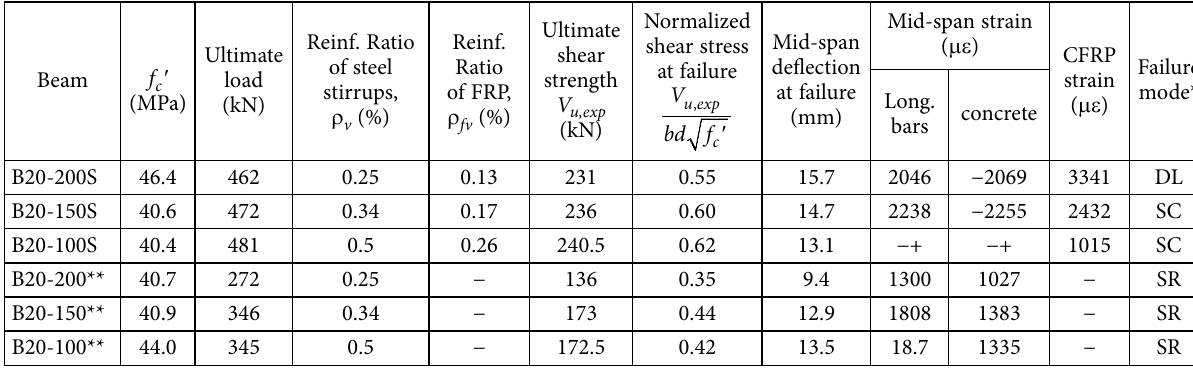
Table 2. Summary of test results